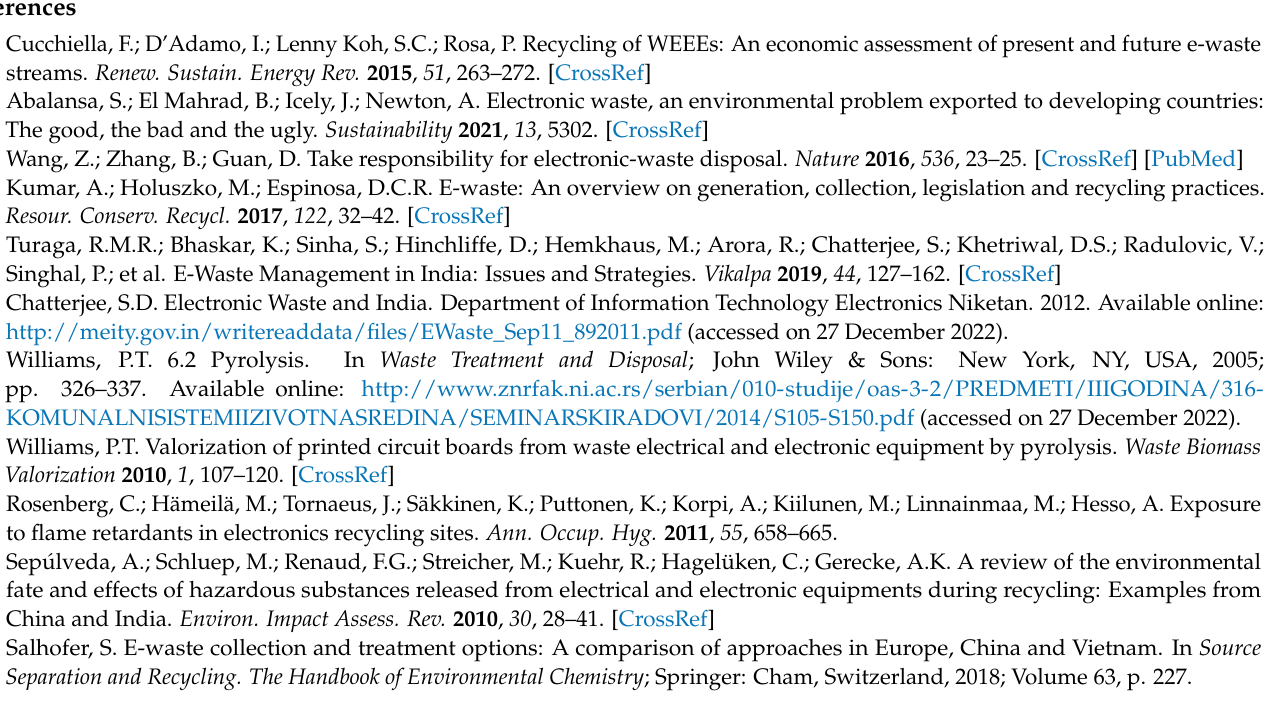
Figure S3: Curve fittings to kinetic model proposed by KAS, FWO and Starink for CS:WPCB 1st (a,b,c) and 2nd (d,e,f)